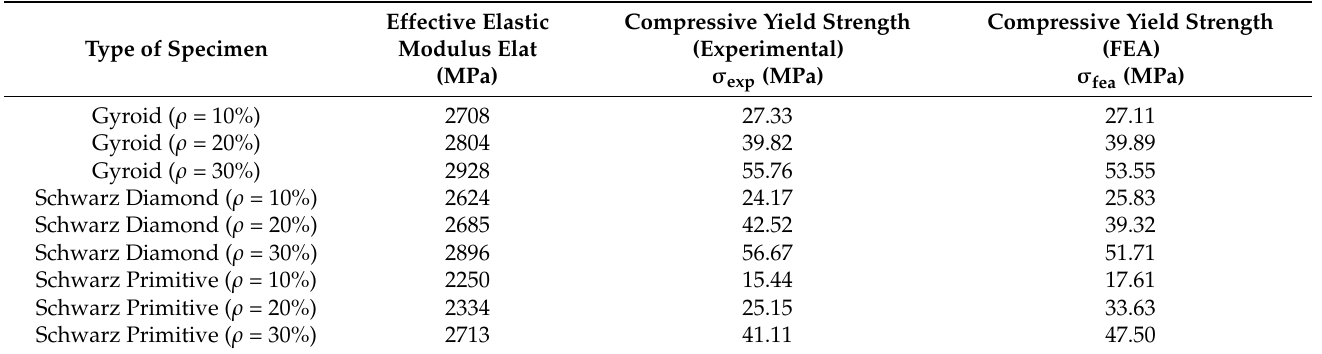
Table 5. Mechanical Properties of the finite element analysis (FEA) printed TPMS